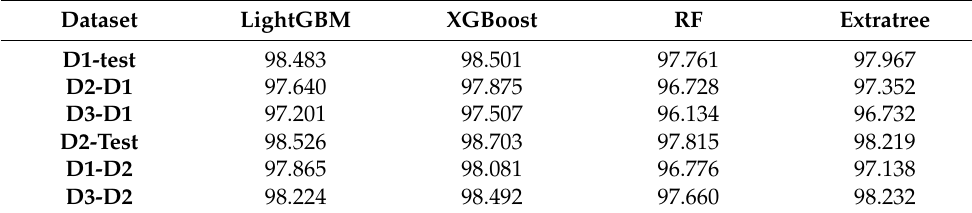
Table 9. Comparison of Accuracy for LightGBM, XGBoost, Random Forest, and Extratree.